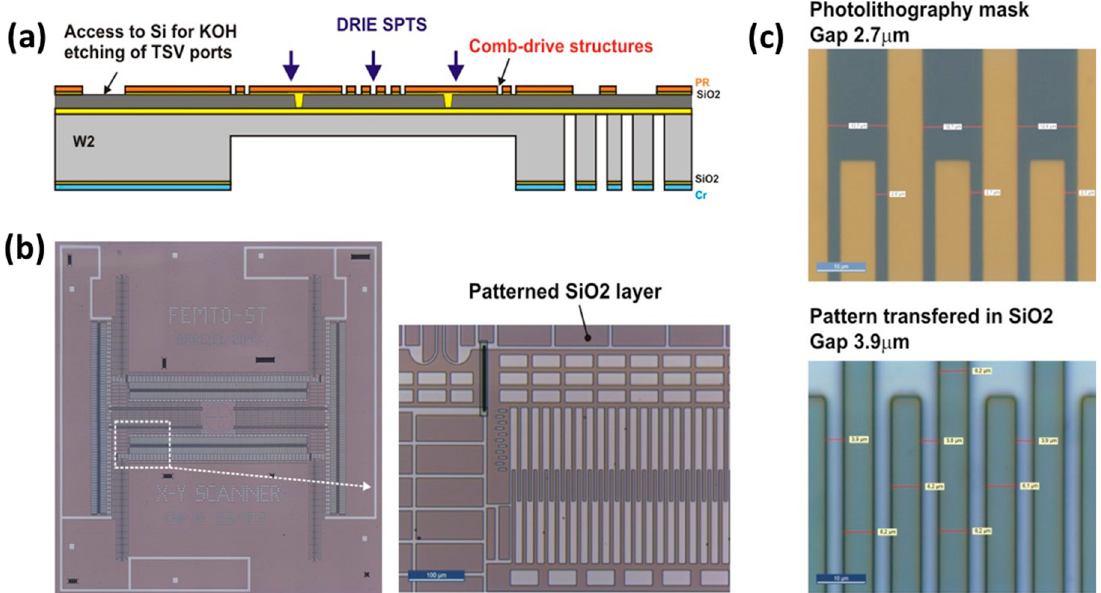
Figure 13. Transfer of precise microactuators pattern into the SiO 2 hard mask layer by use of inductively coupled plasma (ICP) deep reactive ion etching (DRIE): ( a ) the flow chart, ( b ) patterned SiO 2 layer; and, ( c ) measurement results of comb-drive fingers.